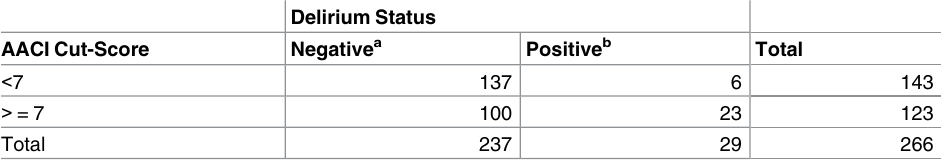
Table 2. Risk of delirium relative to Age-Adjusted Charlson Index (AACI)